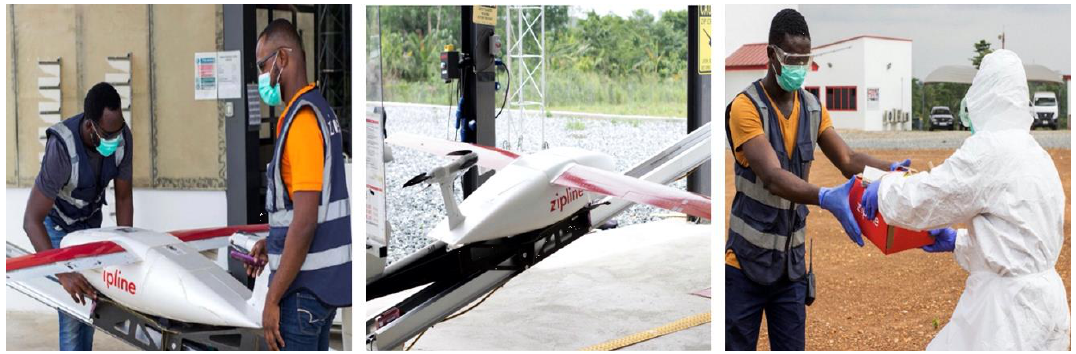
Figure 4. Drone delivery of COVID-19 samples in Ghana (Photo: